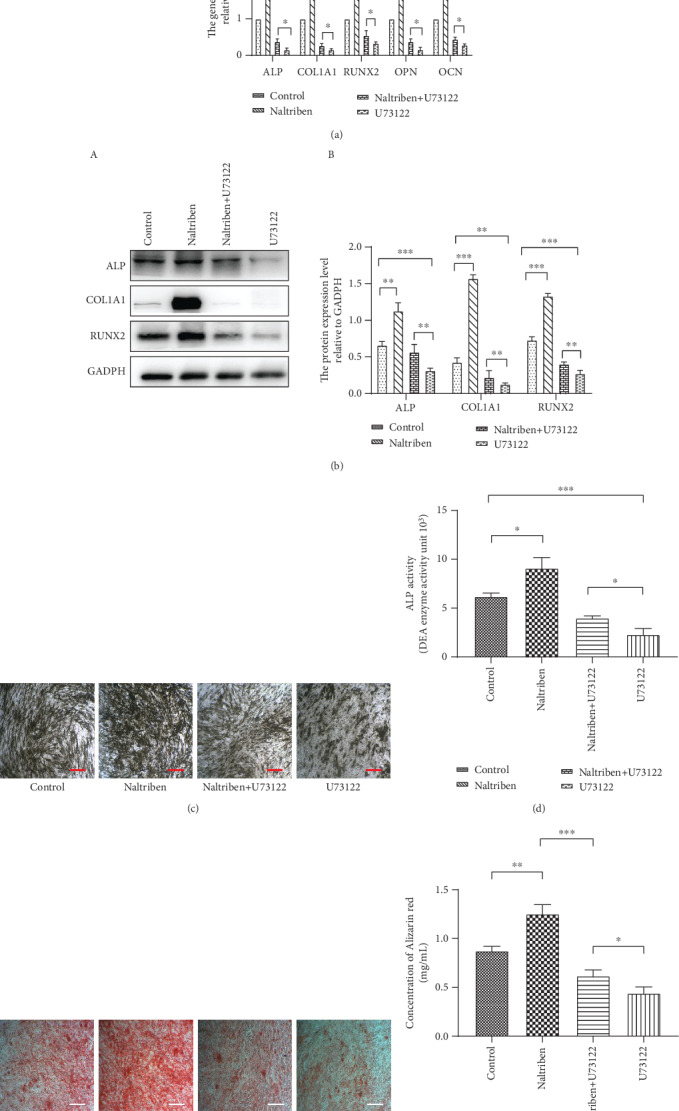
The expression of osteogenic markers and the osteogenic potential of hBMSCs under activating TRPM7 and inhibiting PLC (HSPG2). (a) RT-PCR analysis of osteogenic markers ALP, COL1A1, RUNX2, OPN, and OCN in cells induced with osteogenic medium supplemented with different pharmaceuticals induced for 14 days. (b) (A) Western blot analysis of osteogenic markers in cells induced with osteogenic medium supplemented with different pharmaceuticals induced for 14 days. (B) The relative levels of osteogenic marker proteins were quantified and plotted. (c) Analysis of ALP staining in cells induced with osteogenic medium supplemented with different pharmaceuticals induced for 14 days. (d) Analysis of ALP activity (the unit for p-nitrophenyl: μmol) in cells induced with osteogenic medium supplemented with different pharmaceuticals induced for 14 days. (e) Staining of ARS in cells induced with osteogenic medium supplemented with different pharmaceuticals induced for 14 days. (f) A quantification of ARS in cells induced with osteogenic medium supplemented with different pharmaceuticals induced for 14 days. Scale: 200 μm. Control: cells induced with osteogenic medium without any pharmacological treatment; Naltriben: cells induced with osteogenic medium supplemented with 20 μM Naltriben; Naltriben+U73122: cells induced with osteogenic medium supplemented with 20 μM Naltriben and 1 μM U73122; U73122: cells induced with osteogenic medium supplemented with 1 μM/mL U73122. ∗P < 0.05, ∗∗P < 0.01, and ∗∗∗P < 0.0001.